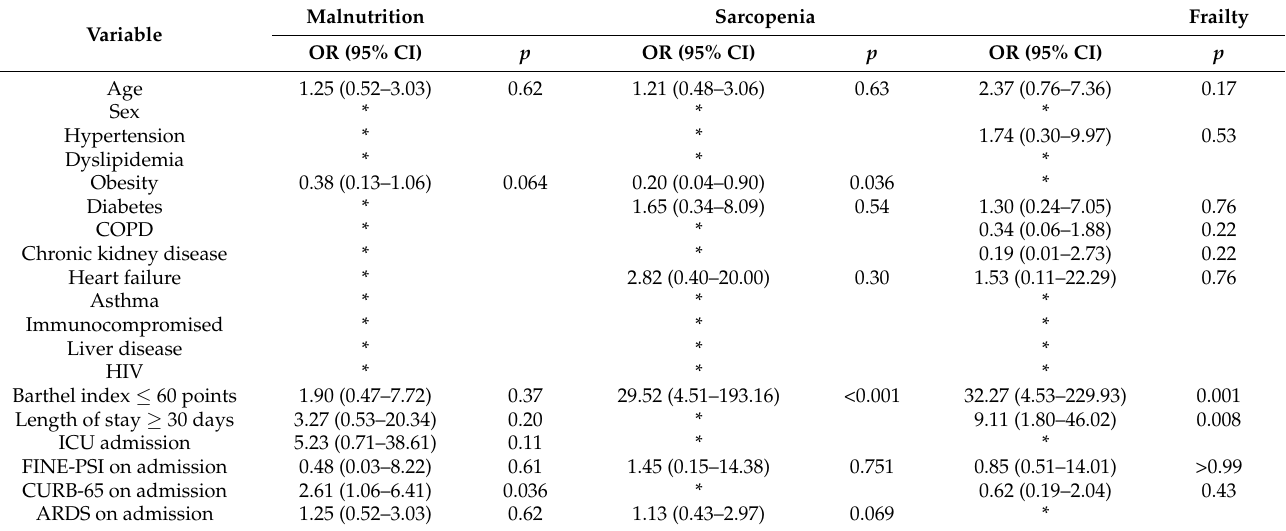
Table 3. Results of multivariable analysis of associations between explanatory variables and the development of malnutrition, sarcopenia, and frailty in patients admitted for COVID-19 infection ( n =